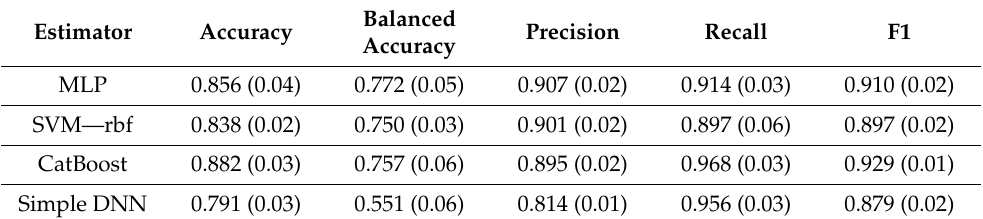
Table 5. Performances for classification task 2: separate movement disorders (Parkinson’s disease and differential diagnoses) from healthy. Values correspond to mean (SD). MLP = multi-layer perceptron, SVM—rbf = support vector machine—radial basis function, simple DNN = simple deep neural network.